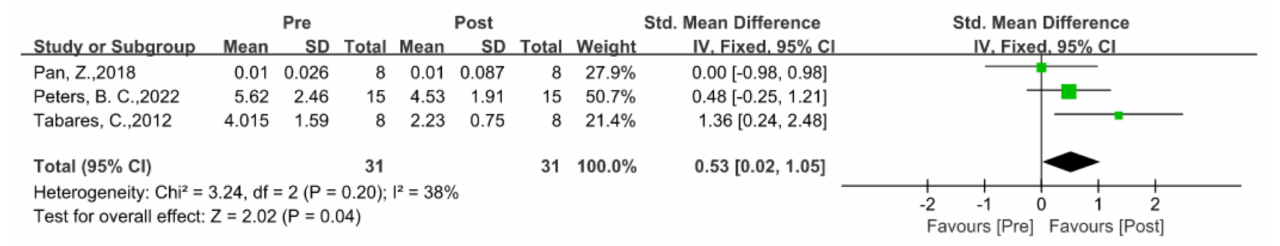
Figure 9. Forest plot of cortisol levels